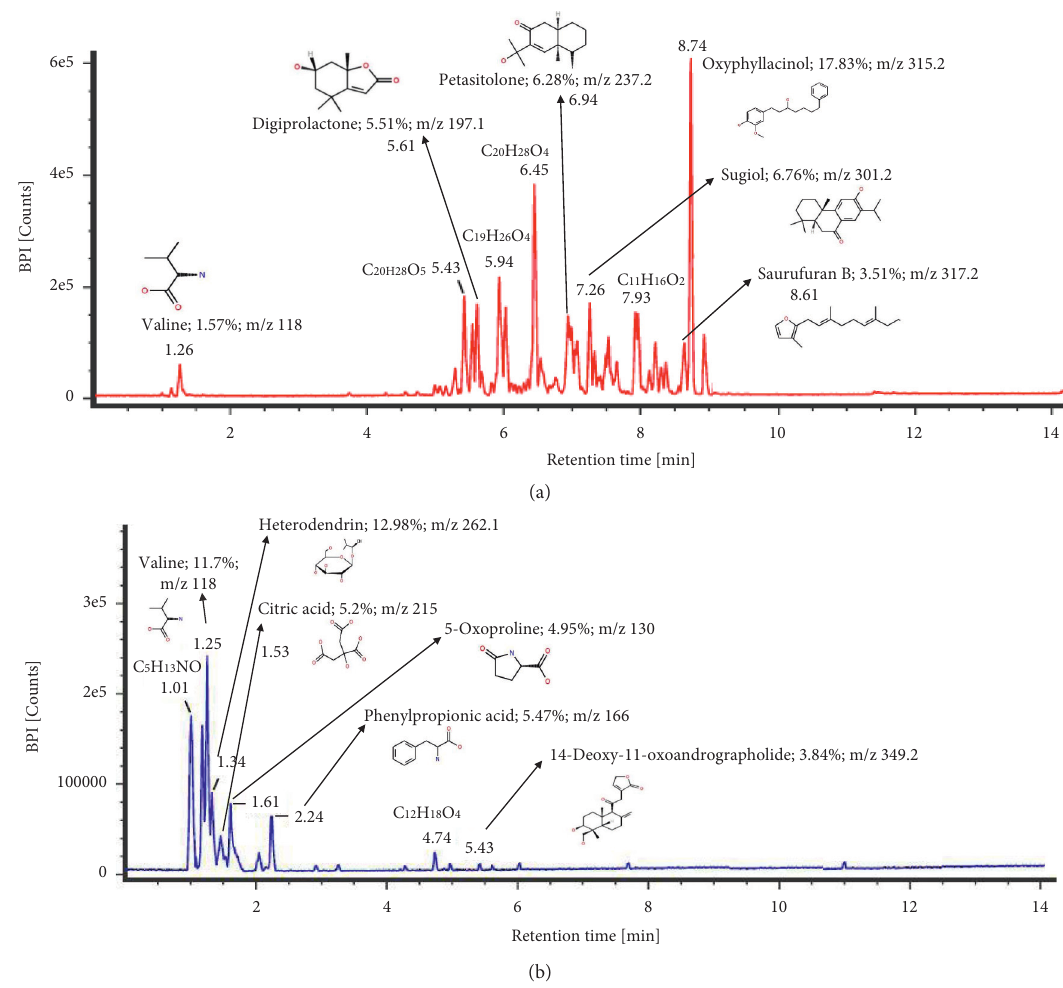
Figure 6: LC-MS/MS profile and predicted compounds of S. nodiflora fractions: (a) water fraction; (b) chloroform